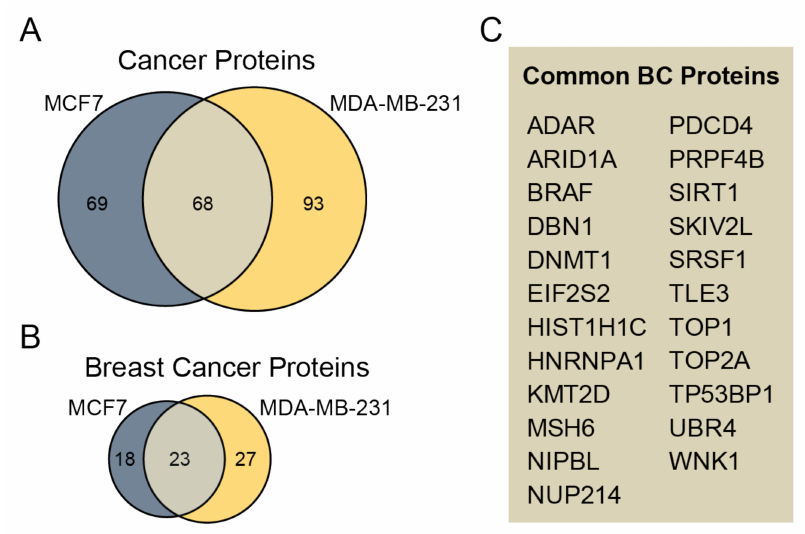
Figure 4. Assessment of identified phosphoproteins related to cancer. ( A ) The Venn diagram compares cancer-related phosphoproteins unique for MCF7 and MDA-MB-231 sEVs. ( B ) The Venn diagram compares the number of phosphoproteins relevant to BC unique for sEVs from cancerous cell lines. ( C ) A list of 23 common BC proteins from MCF7 and MDA-MB-231 sEVs is